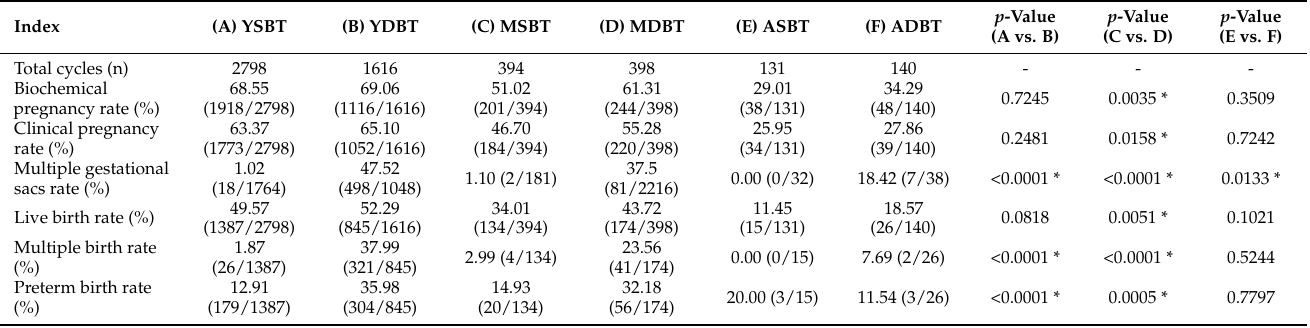
Table 2. Cycle outcomes of the six study